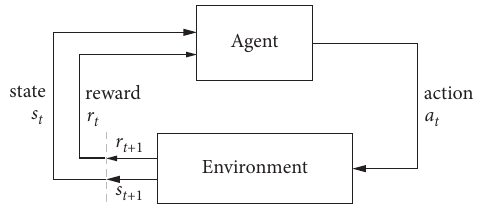
Figure 1: Schematic figure for reinforcement